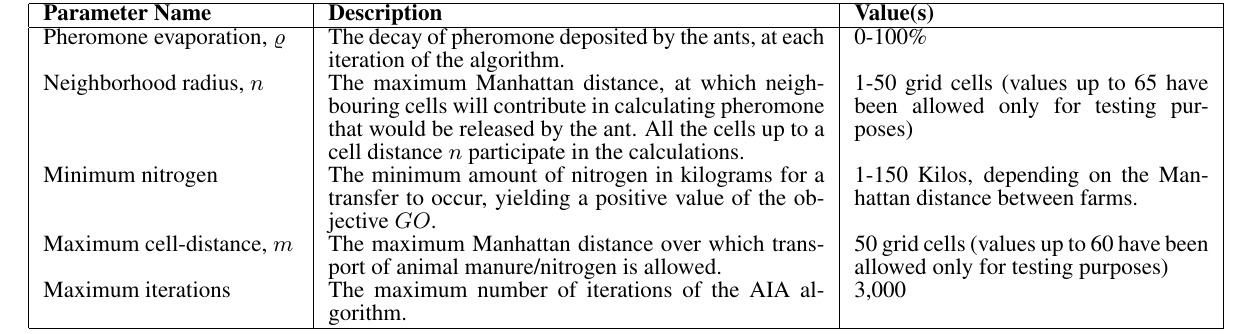
Table 1. Control parameters for the AIA algorithm.